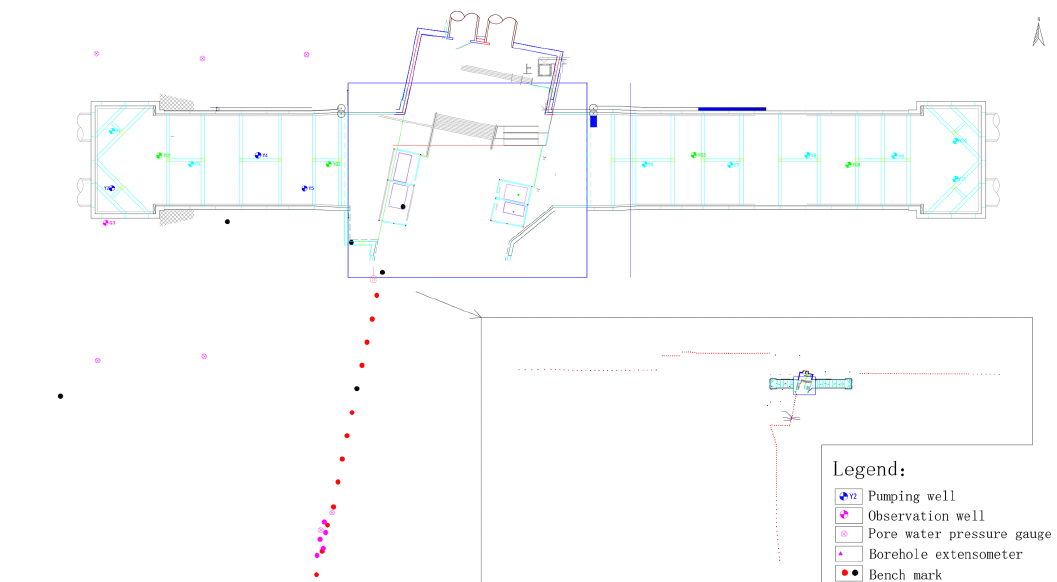
Figure 1. Plane distribution map of foundation pit and its monitoring facilities.